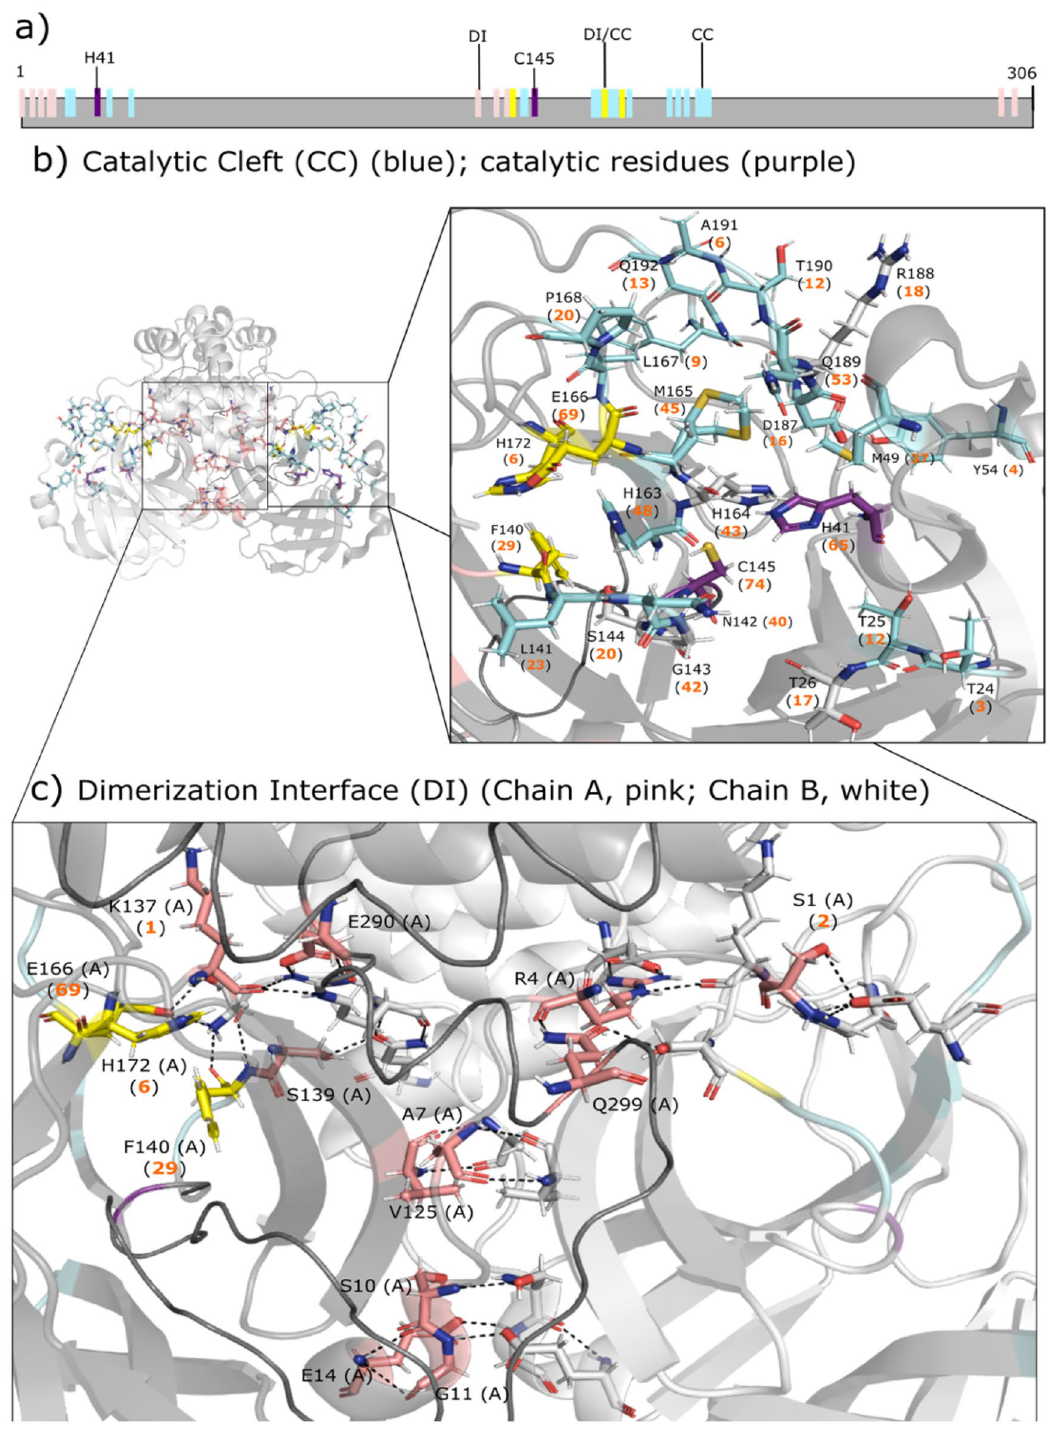
Figure 1. SARS-CoV-2 M pro domain structure and binding sites. ( a ) Diagram showing the catalytic C145–H41 dyad (purple), the substrate-binding residues (light blue) in the catalytic cleft (CC), dimerization interface (DI) residues (pink), and residues shared by the catalytic cleft and dimer interface (yellow). ( b , c ) The 1.65-Å crystal structure of the M pro homodimer (PDB 7ali) with one monomer in light gray and the other in gray. The inset shows the number of drugs (in parentheses) targeting a residue in the catalytic cleft ( b ) and at the dimer interface ( c ). Only residues from chain A are indicated for